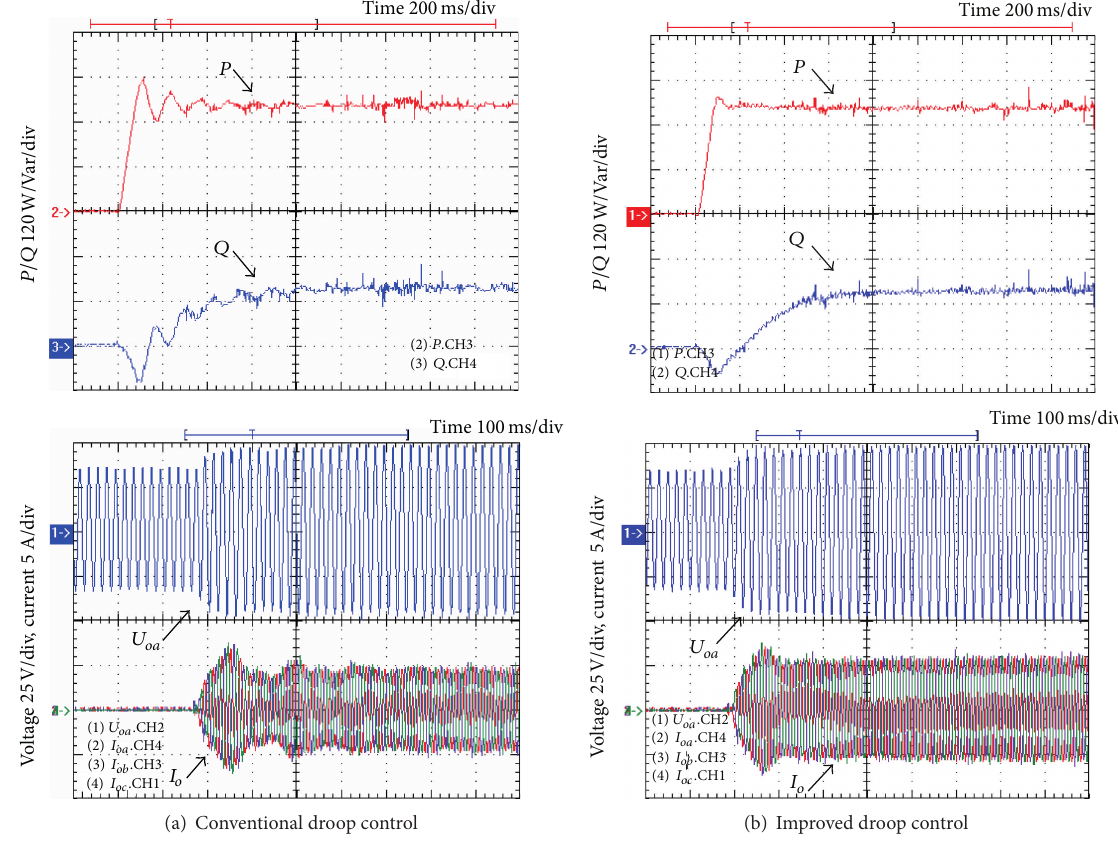
Figure 8: Experimental results of transient responses.